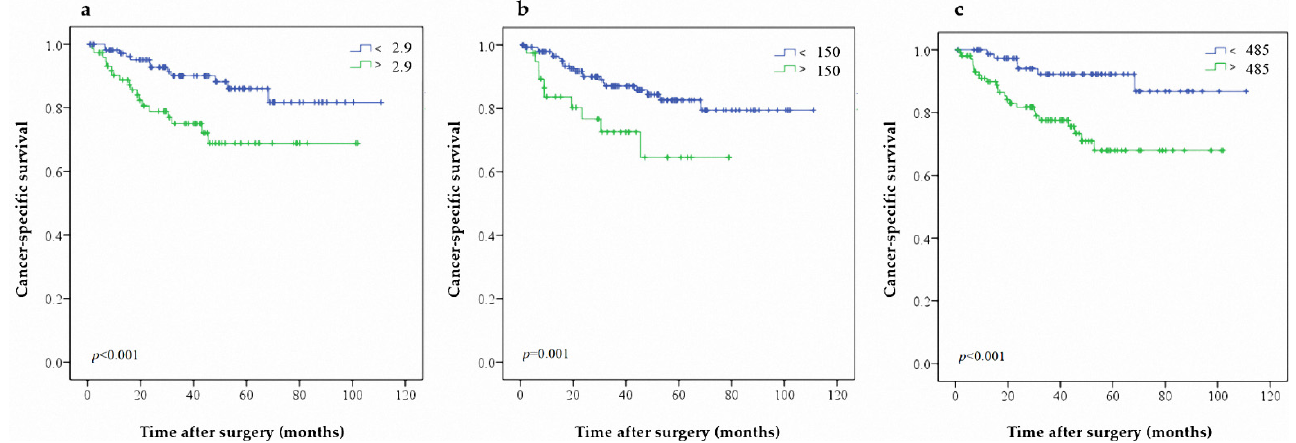
Figure 2. Predictive value of ( a ) NLR ( b ) PLR and ( c ) SII on CSS in patients with UTUC after RNU.